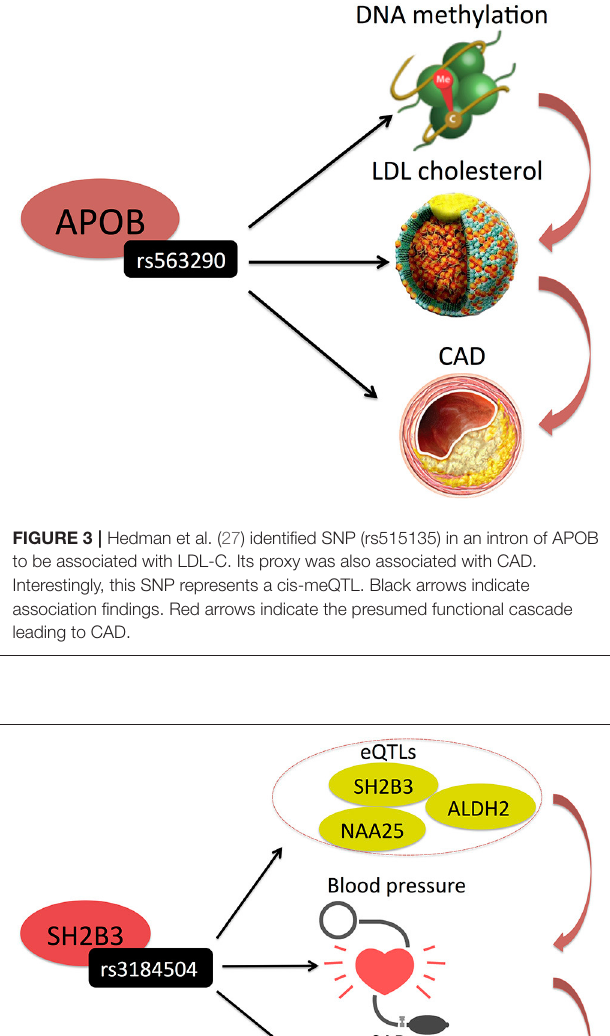
genetic variant (rs2370747) associated with miR-100-5p and miR- 125b-5p expression, a proxy SNP of which was also associated with lipid traits (HDL-, LDL-, and total cholesterol as well as triglycerides). Moreover, it was found that both miRNAs were also differentially expressed in relation to HDL cholesterol (35).